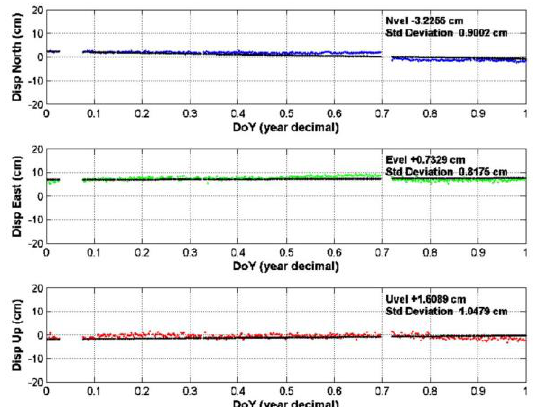
Figure 8. Improved GPS-derived CTS at KUKP after removal of outliers.